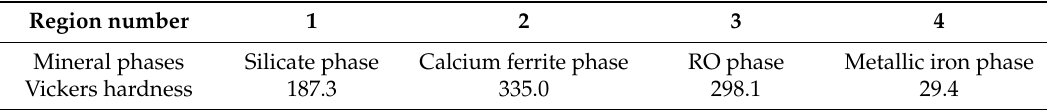
Table 2. Vickers hardness of selected region in Figure 4 (HV).